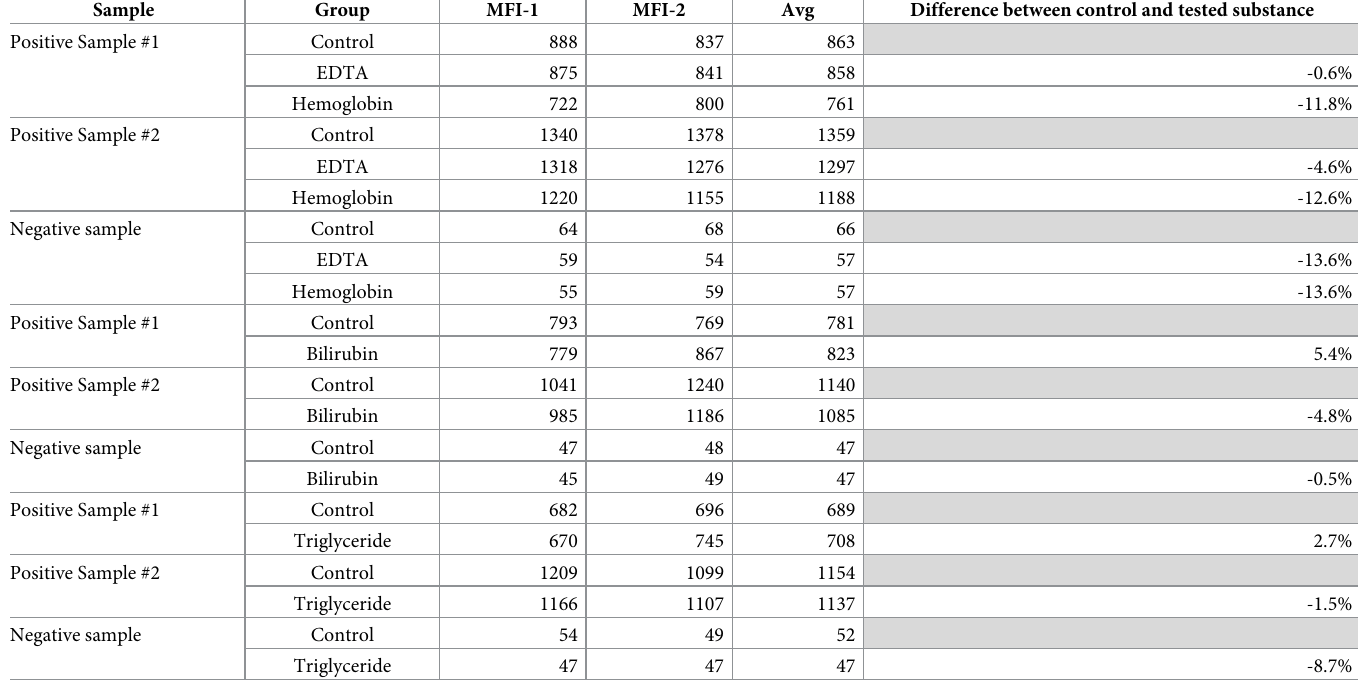
Table 3. Interfering substance